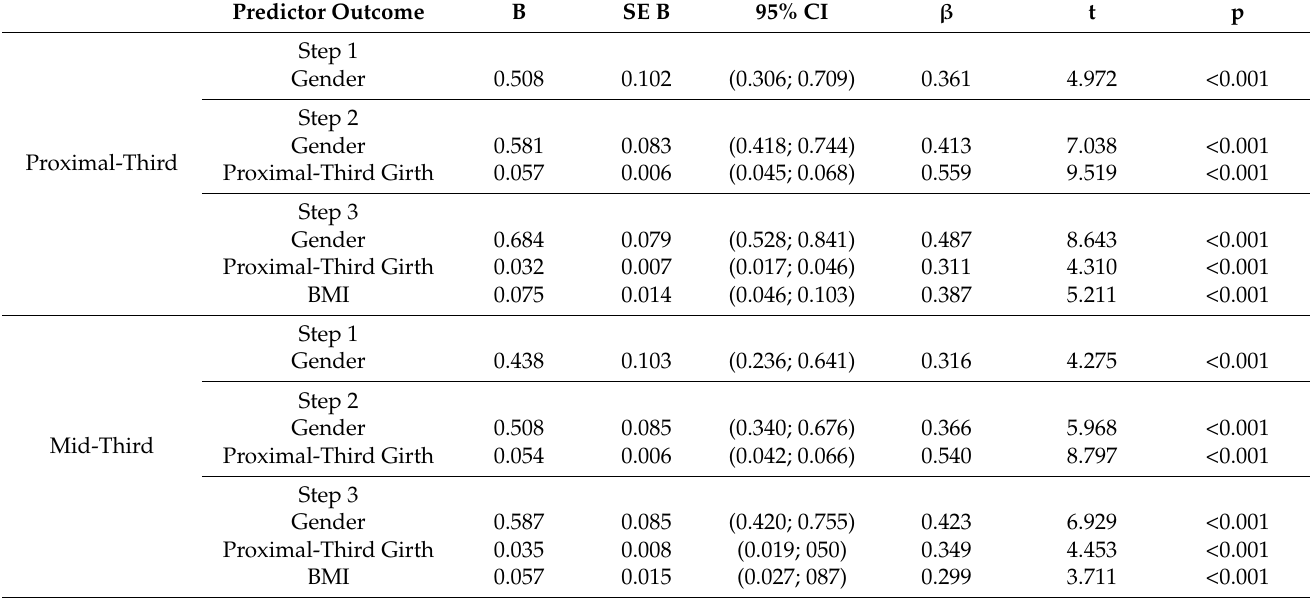
Table 4 describes the hierarchical regression analysis conducted to determine sartorius muscle depth at the proximal third of the thigh. Gender, proximal-third thigh girth, and BMI contributed up to 51.1% of the variance for the proximal-third location and up to 42.6% of the variance for the mid-third. An alternative model including height instead of BMI is detailed in Supplementary Materials (Table S1). Table 4. Summary of the Regression Analyses to determine Predictors of Sartorius